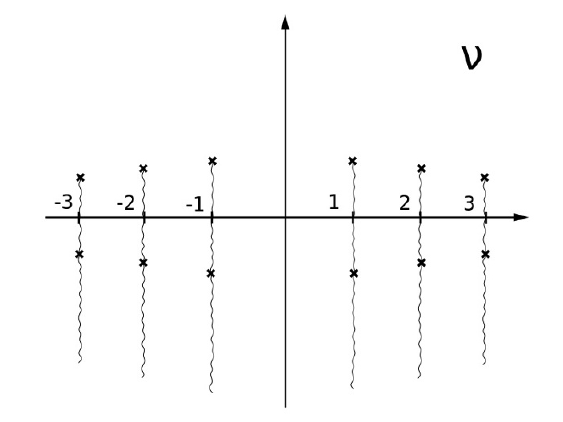
, entering the double series of the semiclassical k